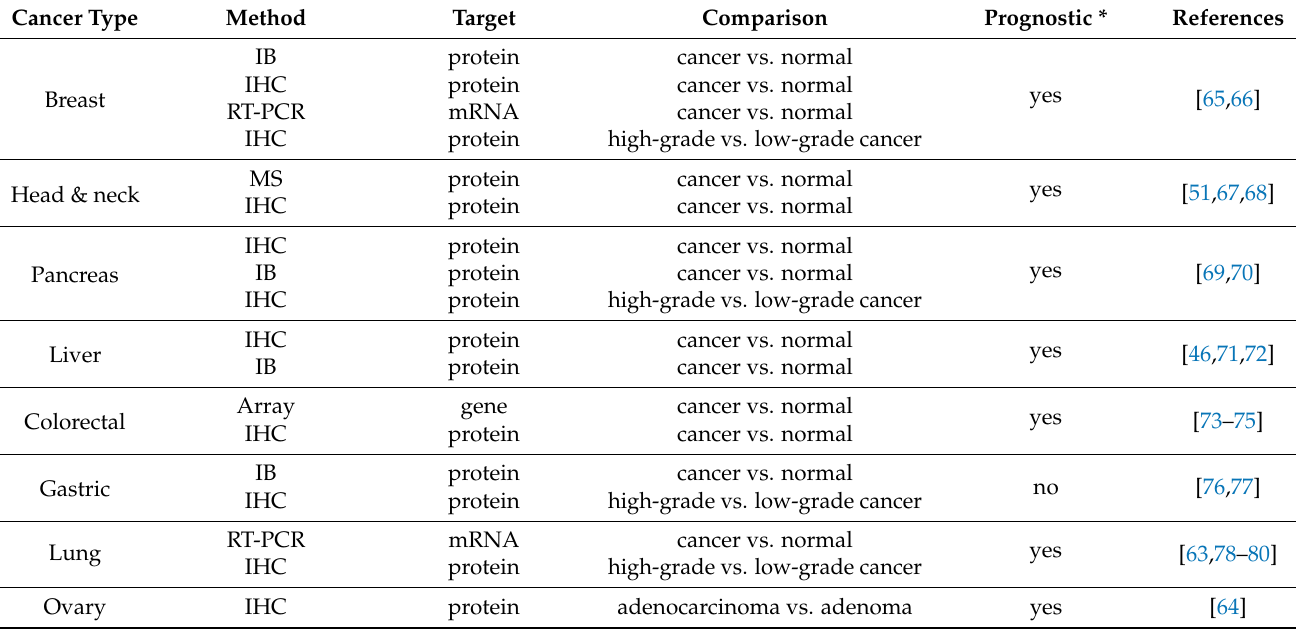
Table 1. List of cancer types with overexpressed